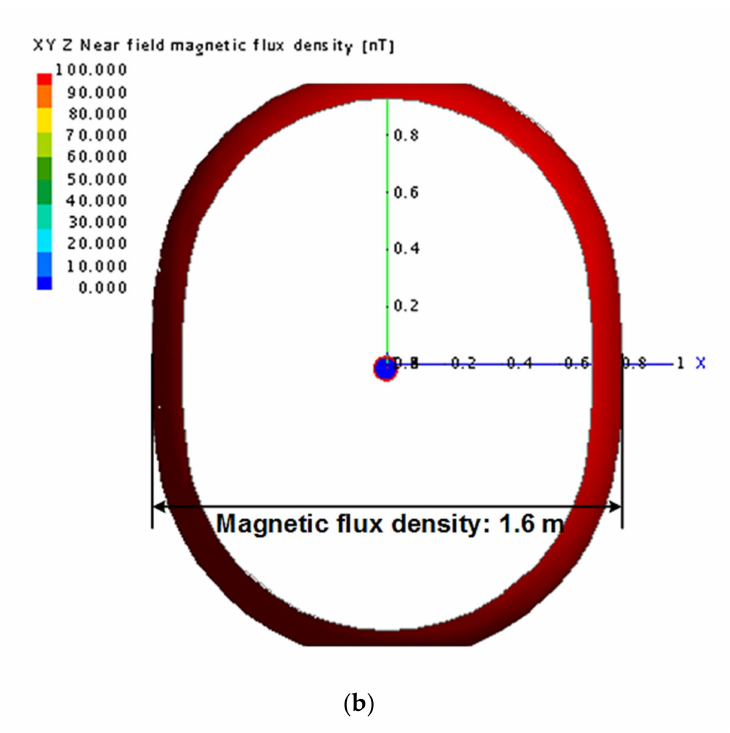
Figure 5. Near-field magnetic flux density of ferrite antenna used in automotive field. ( a ) Keyless entry system; ( b ) smart key system.